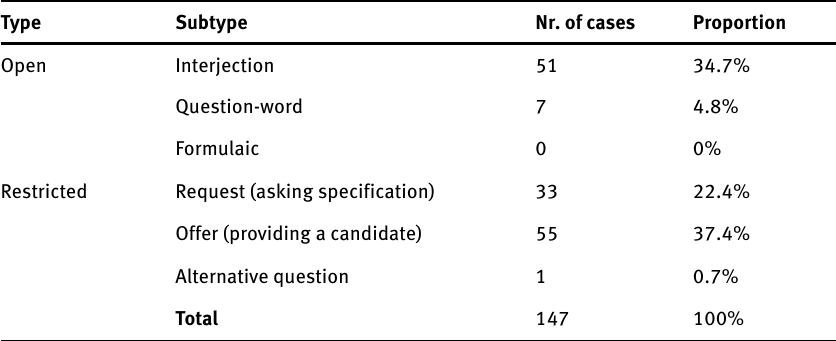
Table 3: Types of repair initiators and their frequency in the Icelandic corpus